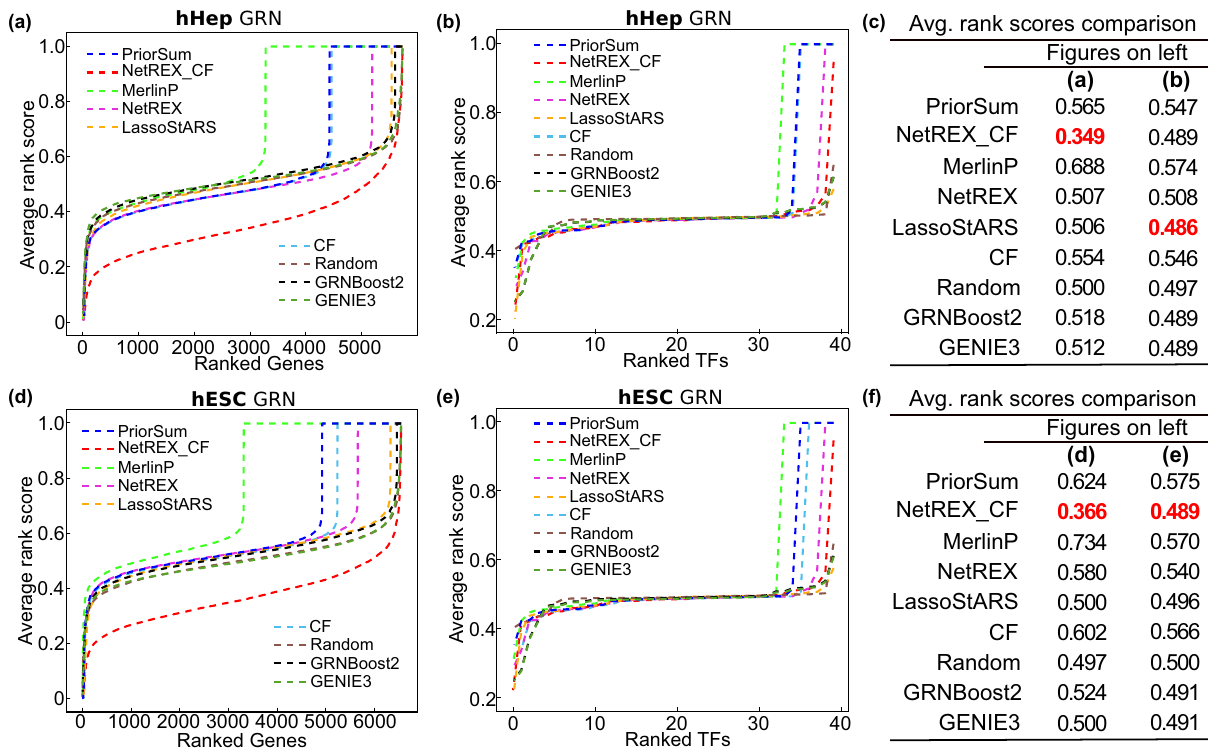
Fig. 5 Performance comparison for all competing algorithms on building cell-speci fi c GRNs from scRNA-Seq results. a The performance of the methods on the task of predicting regulating TFs in hHep GRN. b The performance of the methods on the task of predicting target genes in hHep GRN. c Comparison of the overall ARS in ( a ) and ( b ). The lowest scores are highlighted in bold red. d The performance of the methods on the task of predicting regulating